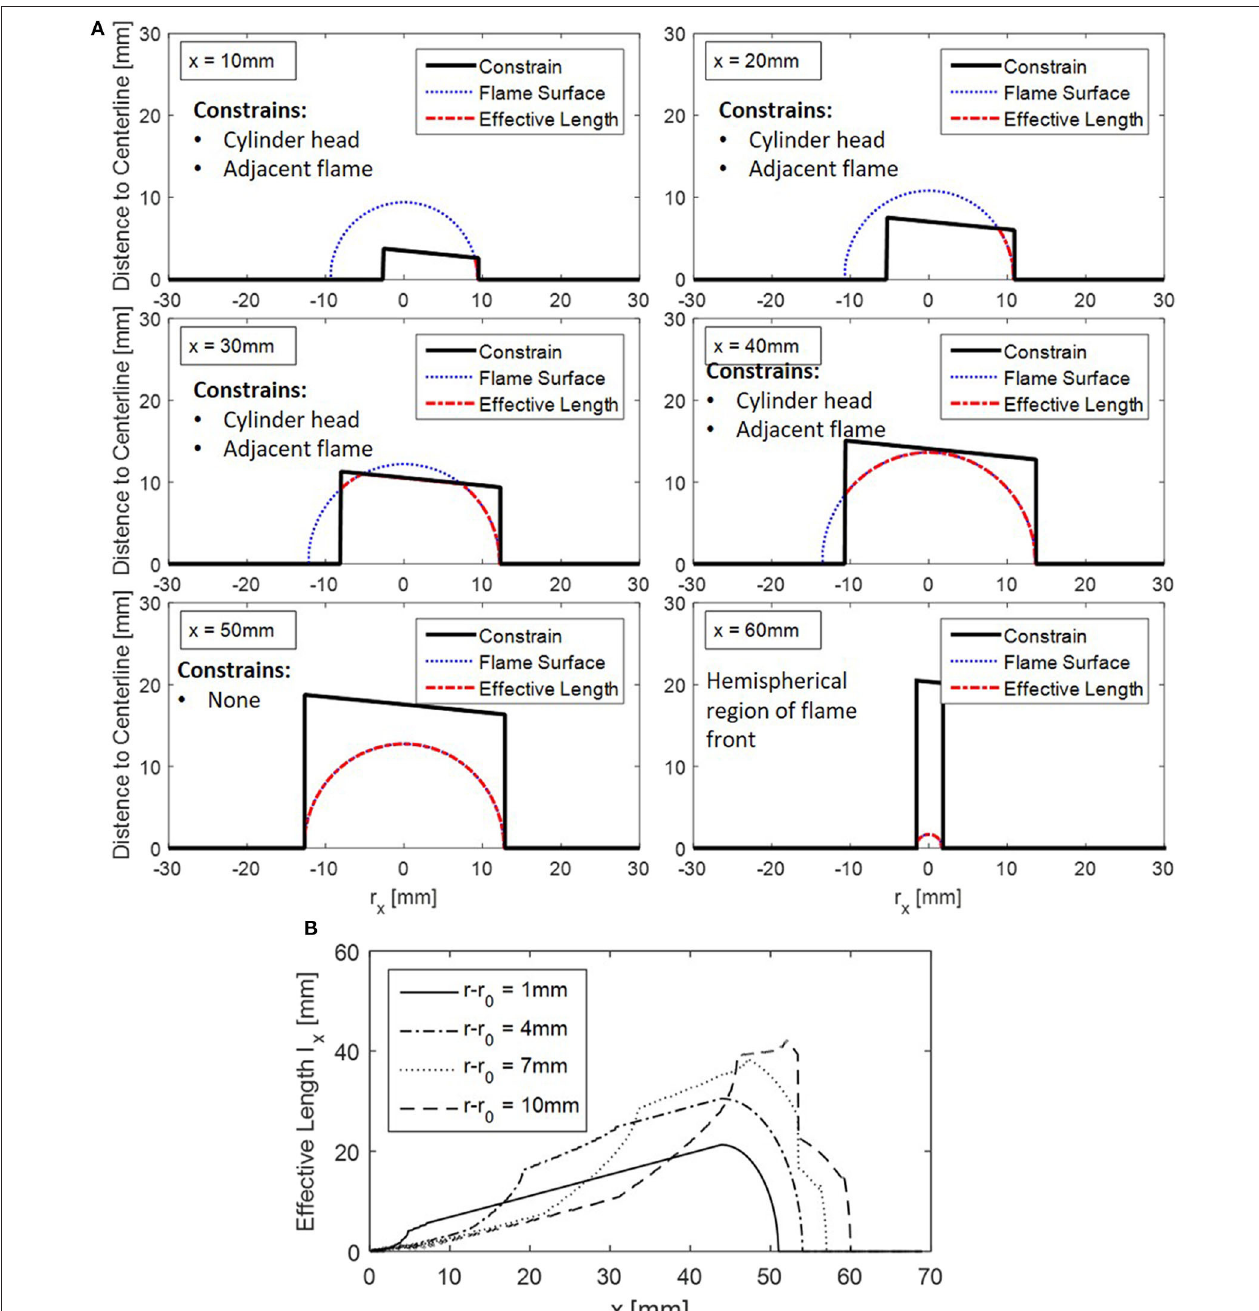
FIGURE 7 | (A) An example of effective flame length calculation. (B) An example of computed effective flame length l x as a function of x and r-r 0 .